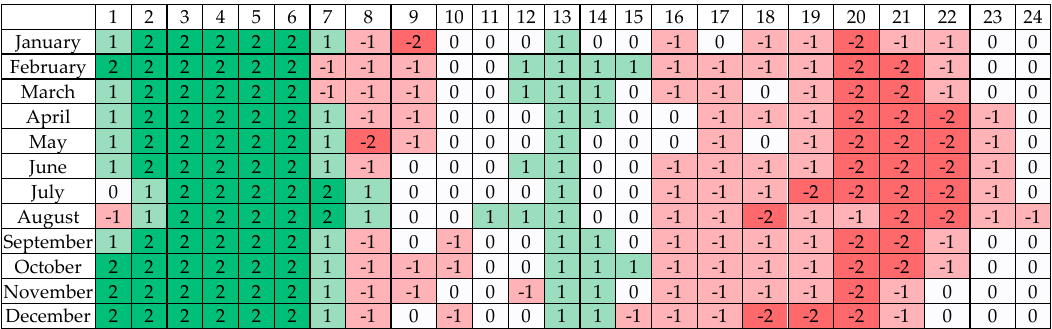
Figure 16. Strategy to optimise the load shifting: weekdays; ( − 2, Green) Strong Load reduction; ( − 1, Light Green) Weak Load reduction; (0, White) No Load variation; (1, Light Red) Weak Load increase; (2, Red) Strong Load increase.